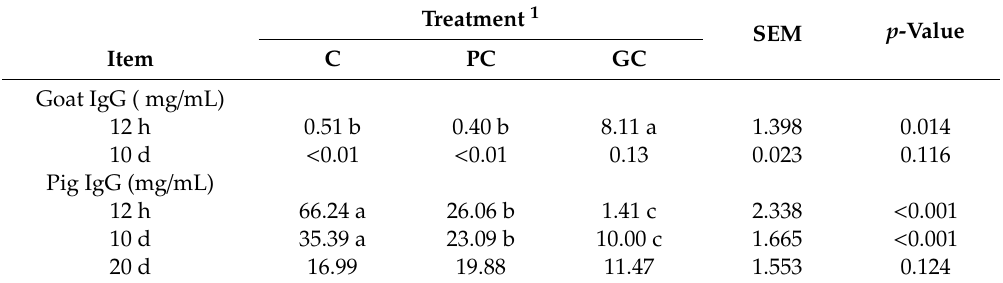
Table 3. Concentration of goat and pig IgG of piglets’ serum across the di ff erent experimental treatments. Treatment 1 SEM p